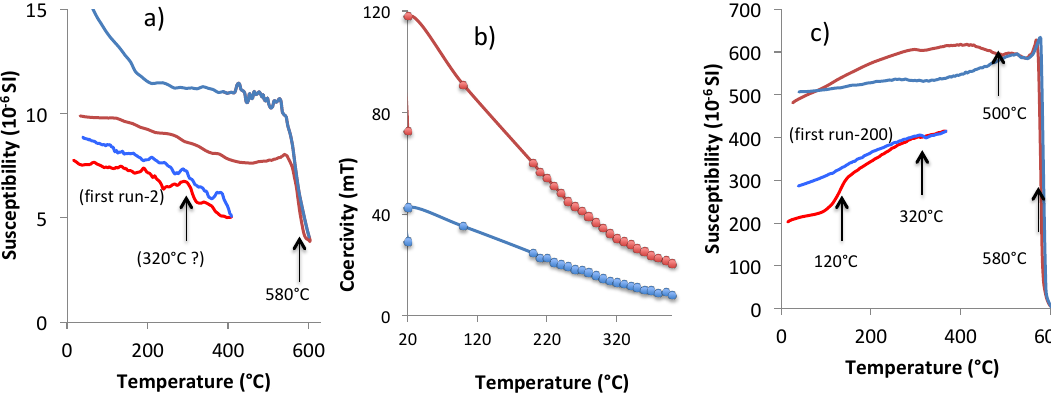
Figure 5. High temperature data for Popigai glasses: ( a ) sample PO-7 susceptibility versus temperature; ( b ) sample PO-7, B CR (red), B C (blue) as a function of temperature during heating; second lower value at room temperature (RT) corresponds to remeasure after heating circle; ( c ) sample PO-23 susceptibility versus temperature. Heating and cooling curves in a) and ( c ) are indicated in red and blue, respectively.